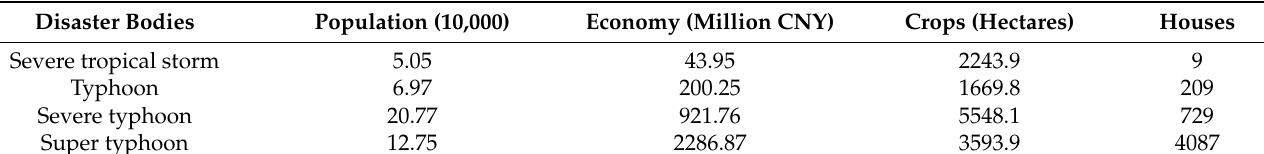
Table 6. Socioeconomic risk of different typhoons in Cangnan County.